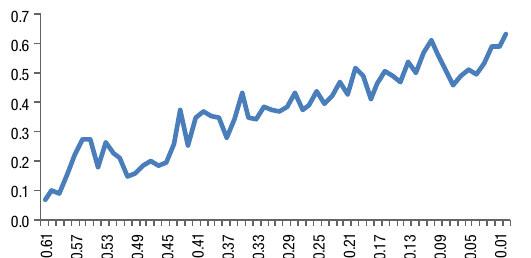
Fig. A.2. Relationship between the probability of increasing the small caps exposure ( p ( t ) values) and the previous small cap weight ( β